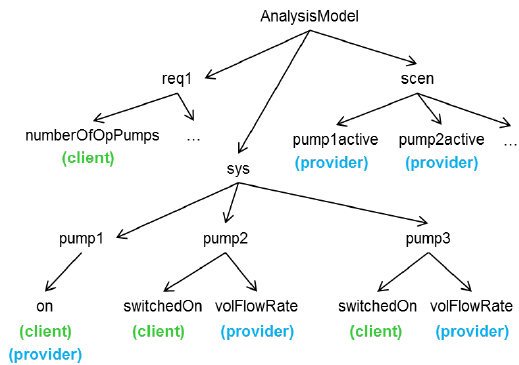
Figure 6: The information that needs to be captured in abstract